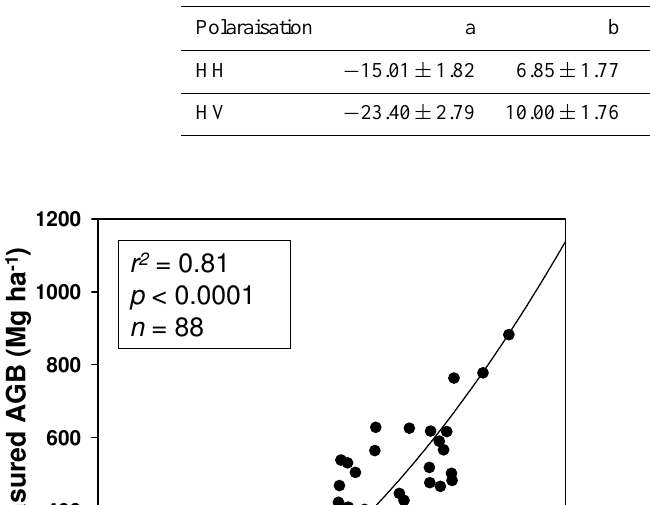
Table 1. Coefficients in radar-biomass regressions ( ± standard errors).